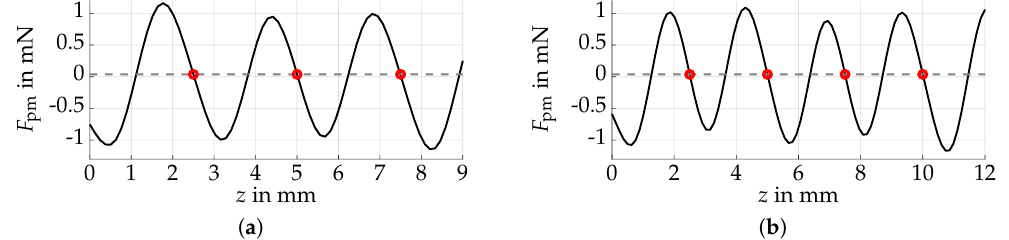
Figure 5. Magnetic force characteristic for the extended, multistable microactuator. ( a ) Setup 3: Three stable equilibria (red circles) were generated by four ring magnets. ( b ) Setup 4: Four resting positions could be achieved with five ring magnets.